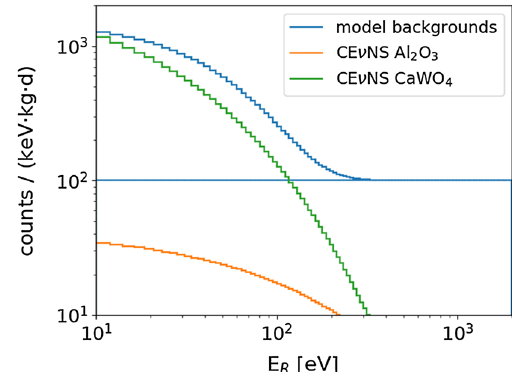
Fig. 13 Comparison of CE ν NS recoil spectra and background models discussed in Sect. 6 in the context of NUCLEUS-10g. The flat back- ground of 100 counts/(keV kg day) taken as a benchmark model in Sect. 6.1 is well above CE ν NS on Al 2 O 3 , while the CaWO 4 recoil spectrum rises above it below 110 eV. The exponential background model (see text) with an amplitude of 1500 counts/(keV kg day) and a slope of 45 eV is similar in shape and normalization to the CaWO 4 CE ν NS signal, therefore it is adopted for the study of NUCLEUS-10g with a non-flat background in Sect. 6.3 (see